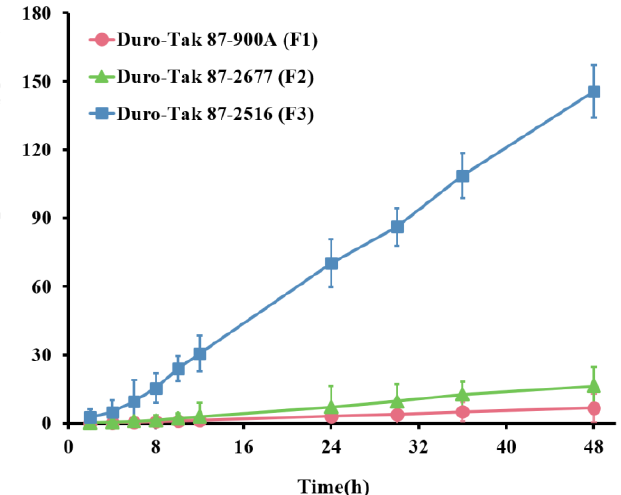
Figure 1. In vitro pig skin permeation profiles of colchicine in patches containing colchicine with highest solubility in various PSAs (mean ± SD, n = 6). Table 2. In vitro pig skin permeation parameters of colchicine in patches containing colchicine with highest solubility in various PSAs (mean ± SD, n =